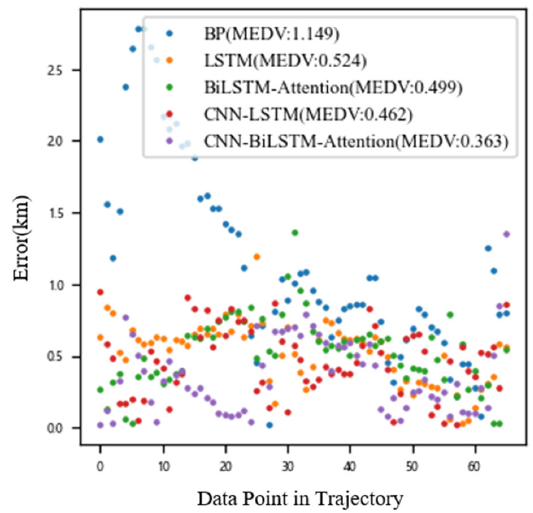
Figure 16. Error scatter plot of five models.